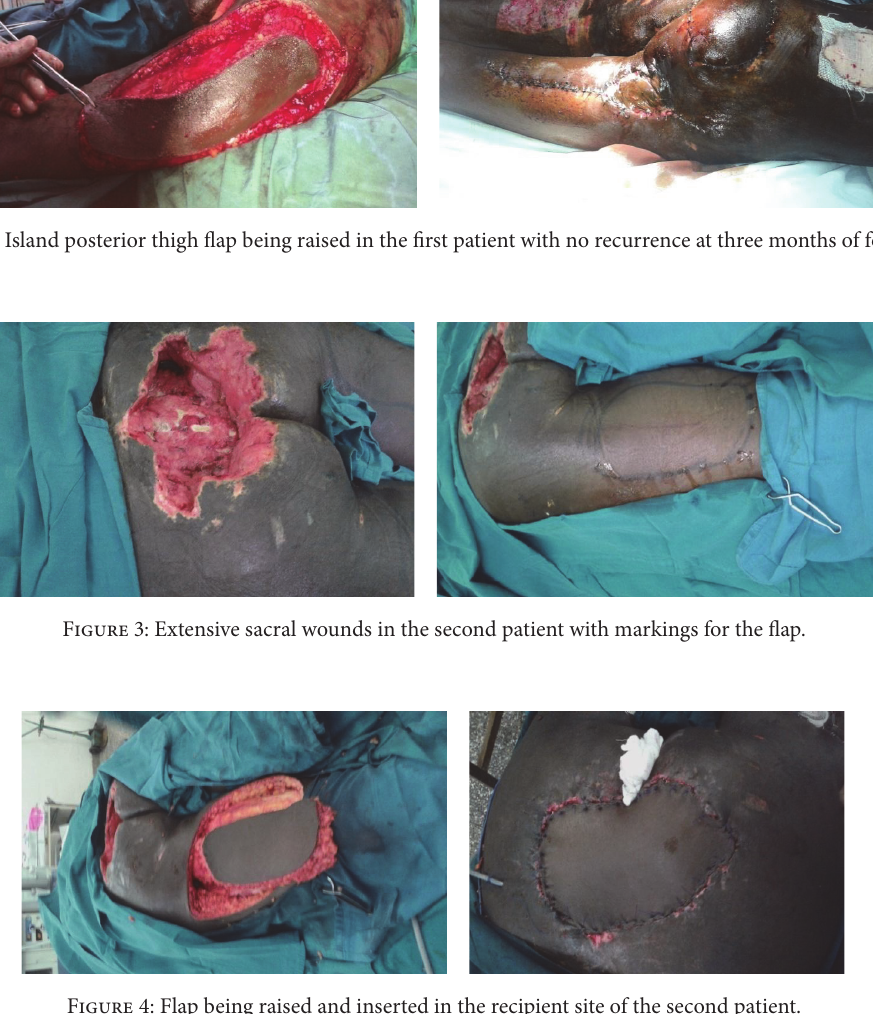
Figure 4: Flap being raised and inserted in the recipient site of the second